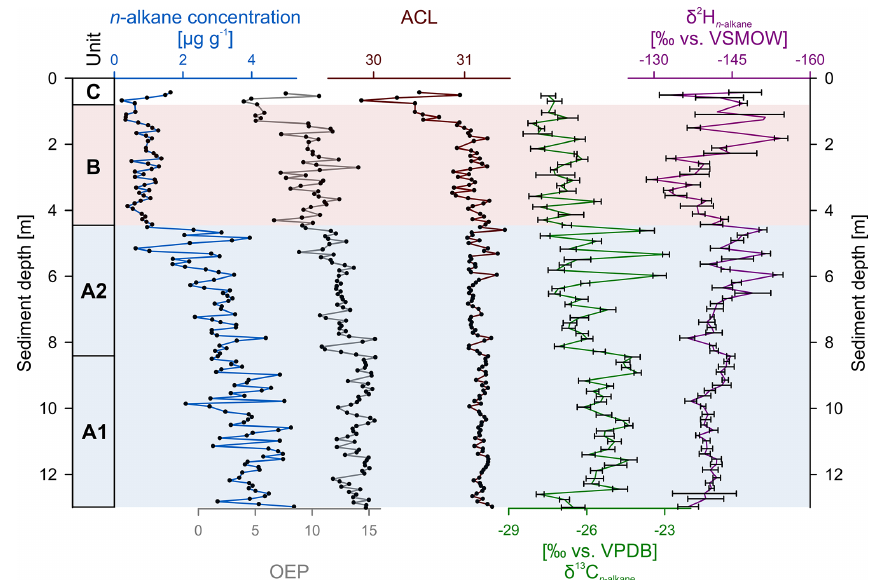
Figure 4. Concentration, odd-over-even predominance (OEP) and average chain length (ACL) of leaf wax n -alkanes and their stable isotopic composition for hydrogen ( δ 2 H n -alkane ) and carbon ( δ 13 C n -alkane ) of the Voëlvlei sediment